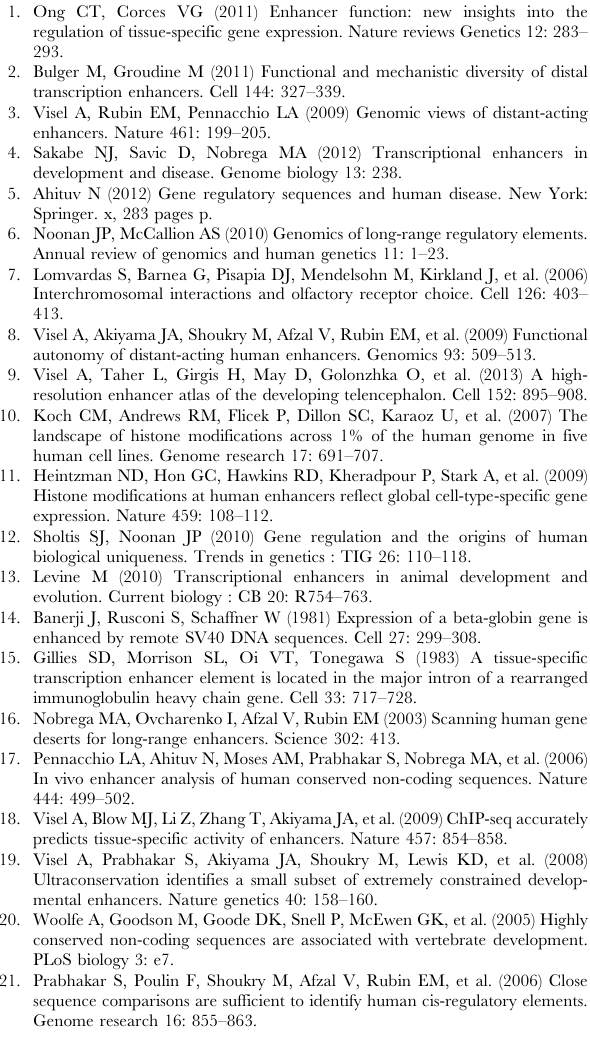
enhancer predictions, along with the MKL scores, for general developmental enhancer activity, brain, heart, and limb enhancers. The general prediction file also lists the H3K27ac and H3K4me1 marks from the feature data overlapping each predicted enhancer. (ZIP) Text S1 Text describing additional analyses in support of the